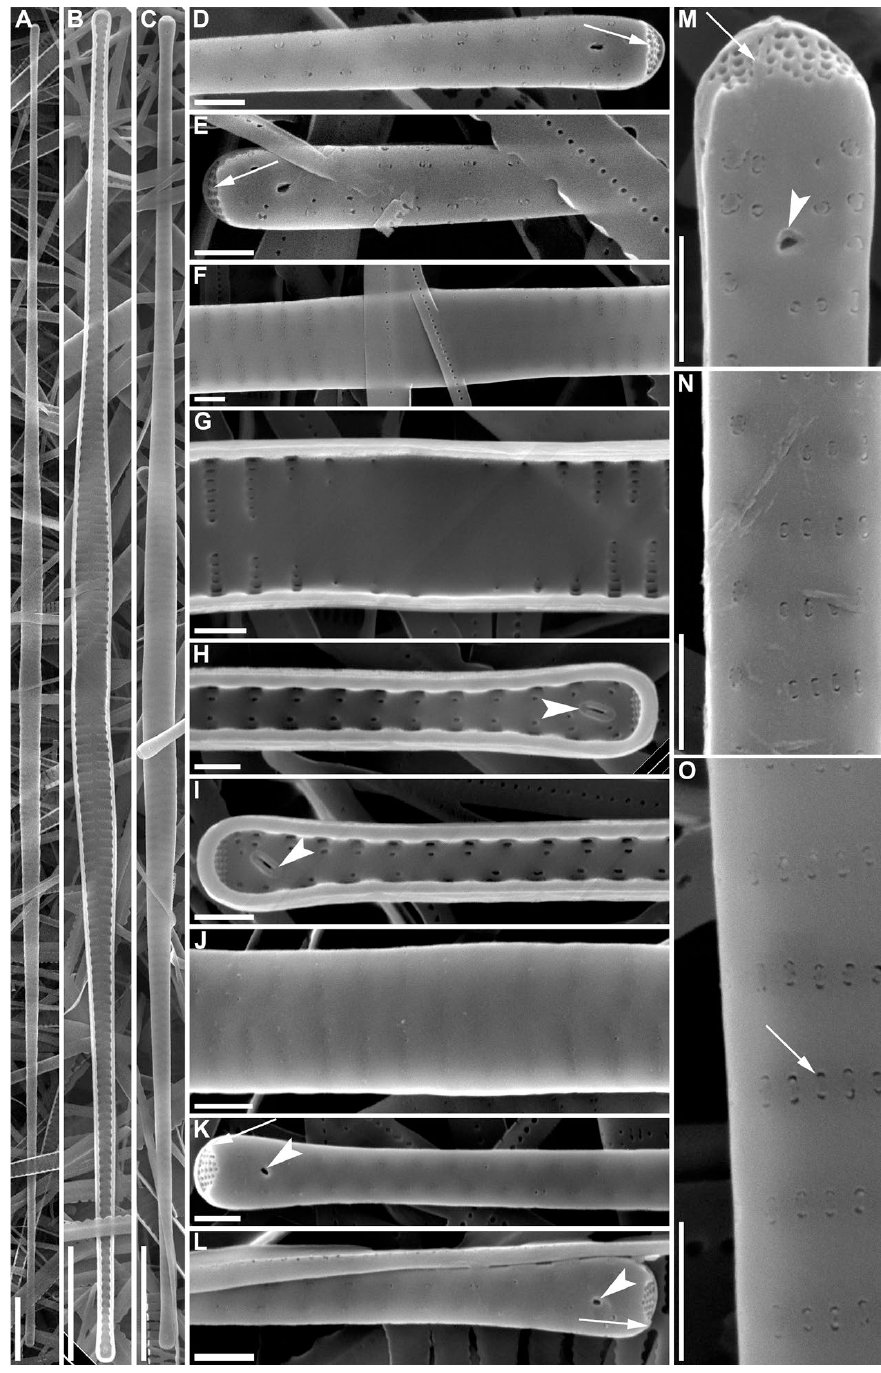
Figure 6. Valve structure of strains Uln1group, strains 3B357 ( A , D – F ), 3B355 ( B , C , F – L , O ) and ACH274 ( M , N ). SEM. Three complete valves: ( A ) valve without apex spines, outside view; ( B ) inside view; ( C ) valve with apex spines, outside view; ( D , E ) apex detail of ( A ) (arrow—ocellulimbus); ( F ) central area detail of ( A ); ( G ) central area detail of ( A ); ( H , I ) apex detail of ( B ) (arrowheads—rimoportula); ( J ) central area detail of ( C ); ( K , L ) apex detail of ( C ) (arrows—apical spines; arrowheads—holes of rimoportula); ( M – O ) fine structure of areolae and velums on different valve area of different strains (arrowhead—a hole of rimoportula; arrow—flat velum on the areolae). Scale bar: ( A – C )—10 μm; ( D – O )—1 μm.